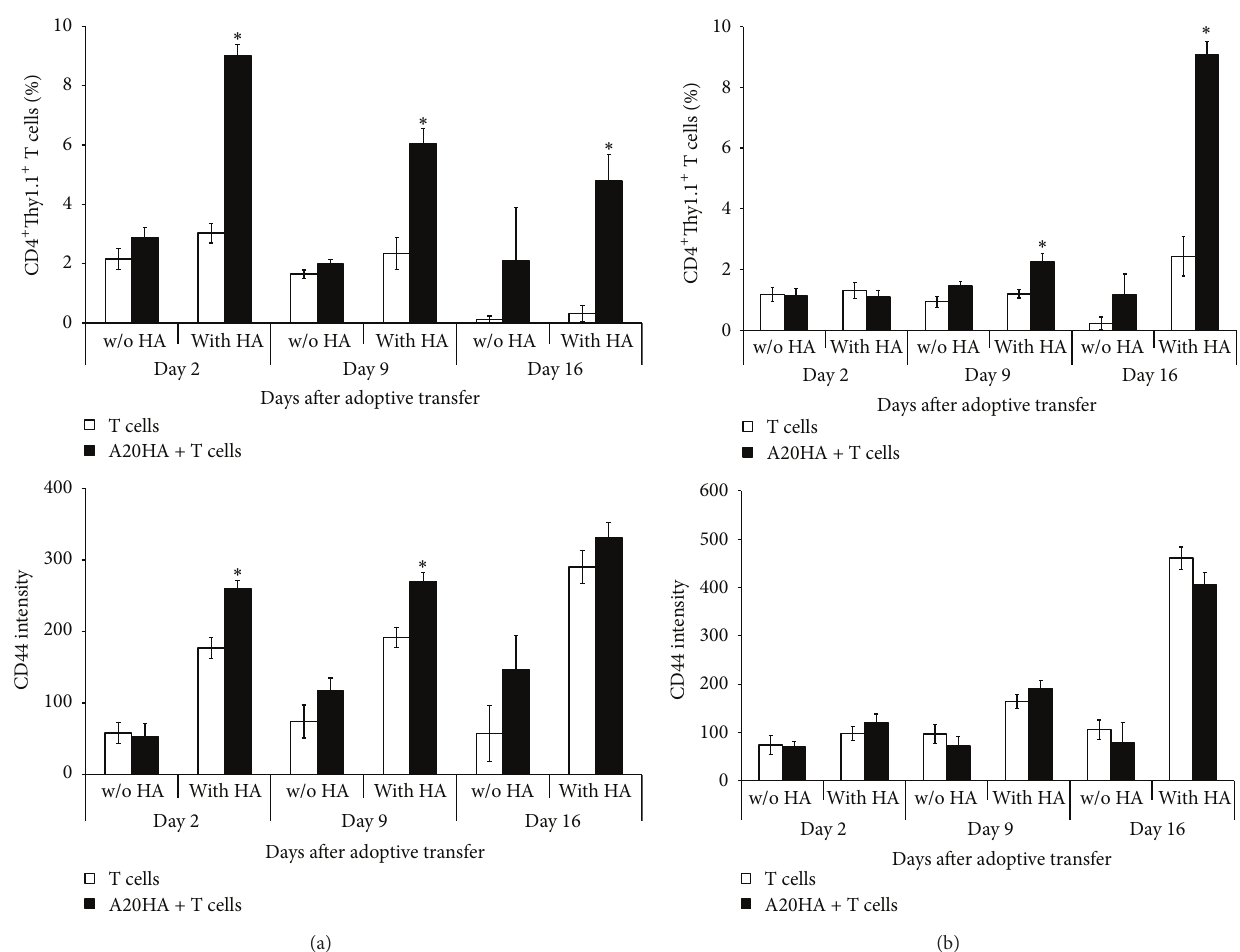
Figure 4: Response of HA-specific CD4 + Thy-1.1 + T cells from cervical lymph nodes of A20HA brain tumor-bearing mice to HA peptide in vitro is reduced in process of the tumor progression and controversial to response of CD4 + T cells from spleen. ((a), (b)) Percent of CD4 + Thy- 1.1 + T cells (upper) and intensity of CD44 expression (lower) by cells isolated from (a) cervical lymph nodes and (b) spleens on days 2, 9, and 16 after the adoptive transfer. HA-specific CD4 + Thy1.1 + T cells were injected i.v. into A20HA brain tumor-bearing mice 5 days after i.c. tumor inoculation (A20HA + T cells) and tumor-free control mice (T cells). A20HA brain tumor-bearing mice in the absence of HA-specific CD4 + Thy1.1 + T cells represented a negative control (background staining of a specified area was lesser than 0.01%; data not shown). Cervical lymph nodes and spleens were pooled and analyzed by FACS for CD4 + Thy1.1 + CD44 + T cells before incubation and after 72 h incubation without (w/o) and with HA peptide. FACS data are presented as a percent of double positive cells, CD4 versus Thy1.1, and the level of CD44 expression in the CD4 + Thy1.1 + T-cell population. One representative experiment of equivalent two is shown. ∗ 𝑃 < 0.05